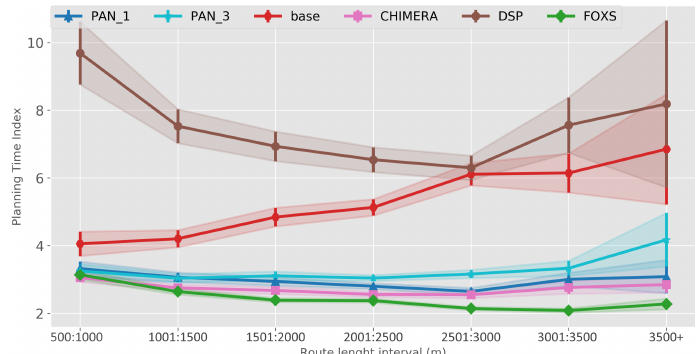
Figure 20. PTI by route size—Cologne Scenario.